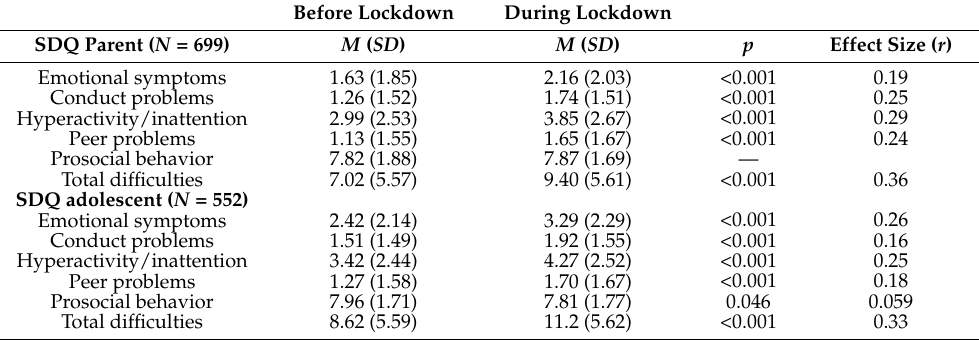
Table 2. Changes in psychological symptoms before and during the COVID-19